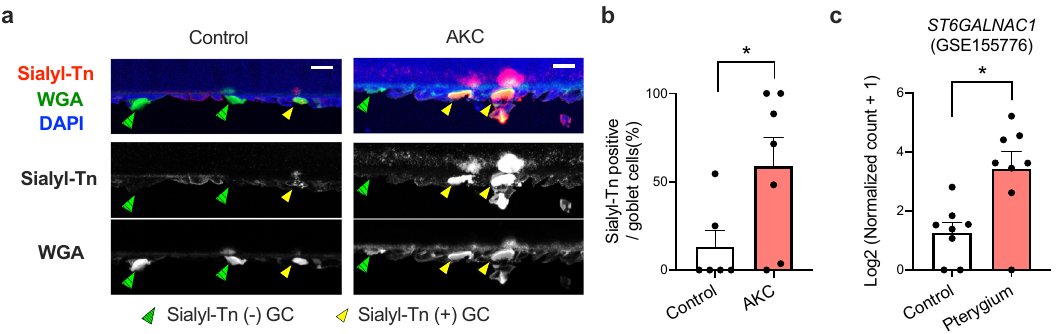
Fig. 7 | Sialyl-Tn or ST6GALNAC1 is upregulated in chronic stimulatory condi- tions in humans. a Representative immunostaining of impression cytology spe- cimens.GC,gobletcells.Bar,20 μ m. b Frequenciesofsialyl-Tn-positivegobletcells in impression cytology specimens from control ( n =6) and AKC ( n =7) subjects. test.ErrorbarrepresentsS.E.M.SourcedataareprovidedasaSourceData fi le( a , b